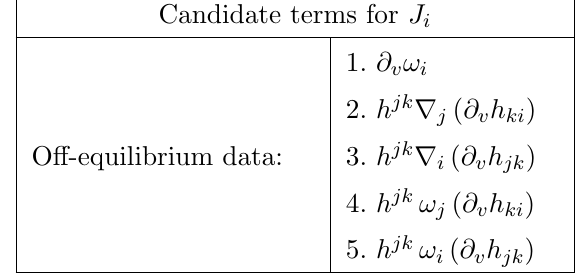
Table 10 . Possible structures that can appear in J i : each one of them has two derivatives and boost weight=